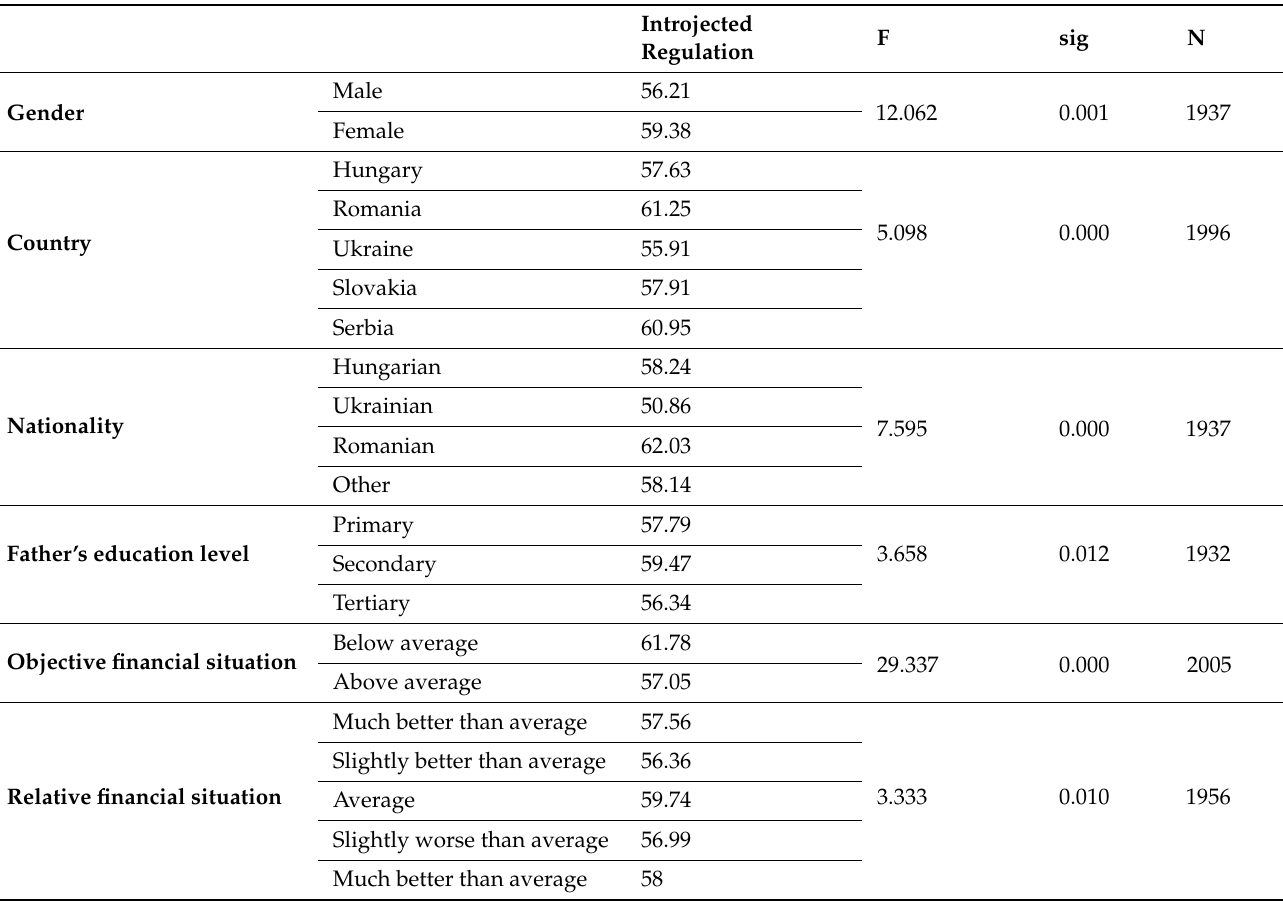
Table A6. Sociocultural and demographic background of introjected regulation. Source: PERSIST